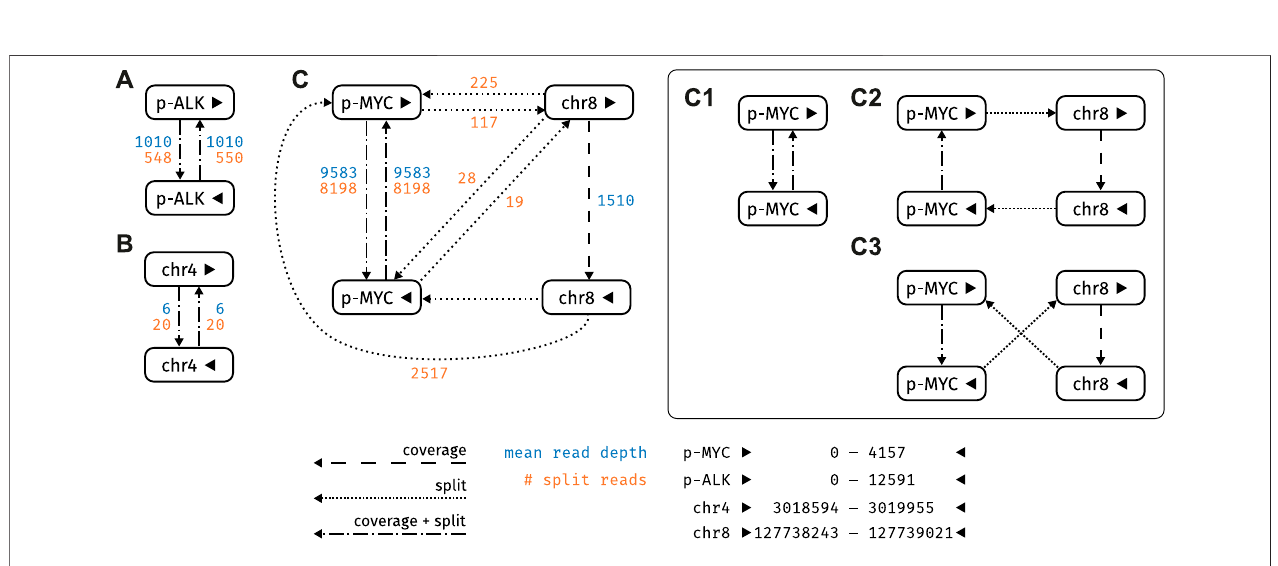
FIGURE 6 | Graph structure of the strongly connected components (SCC) of the plasmid sample. Nodes refer to reference loci, edges as described in Section 2.2.2 (A) SCC containing ALK_pLenti (posterior probability 1.0) (B) SCC with an off-target hit on chromosome 4 (posterior probability 0.0) (C) SCC containing pDONR223_MYC_WT: This SCC encompasses three plausible circular paths (C1) (C2) and (C3) , all of which are equally likely (posterior probability